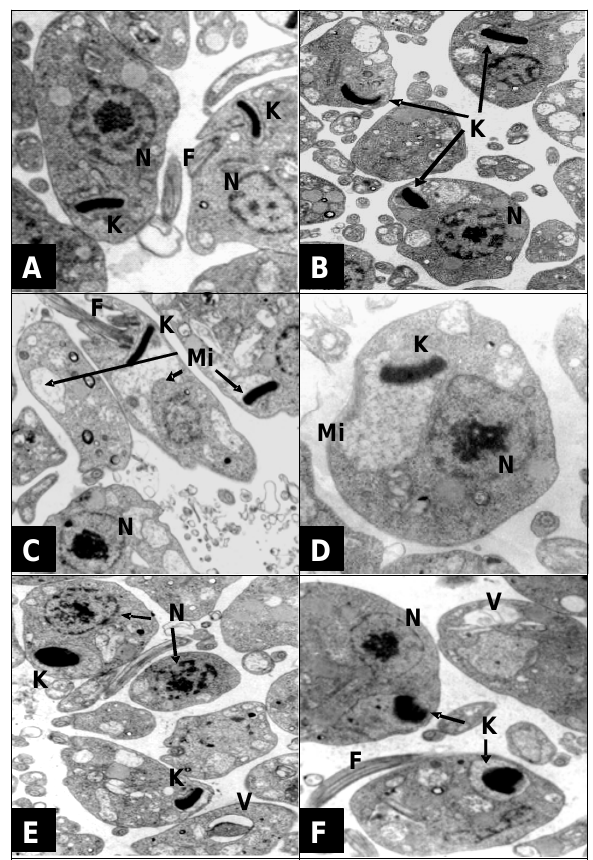
Figure 4. Effect of psilostachyin on ultrastructure of T. cruzi